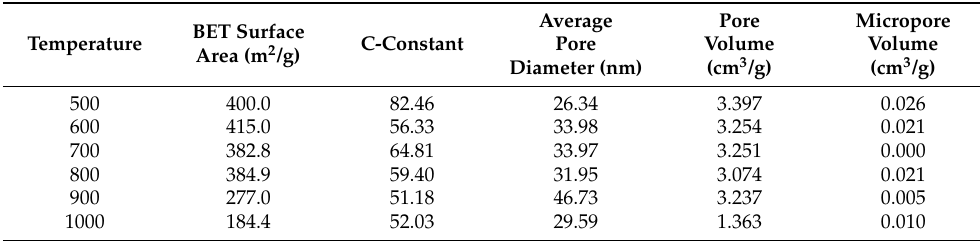
Table 1. Specific surface area, C-constant values, average pore diameters, cumulative pore volumes, and micropore contributions of the composite samples as a function of the sintering